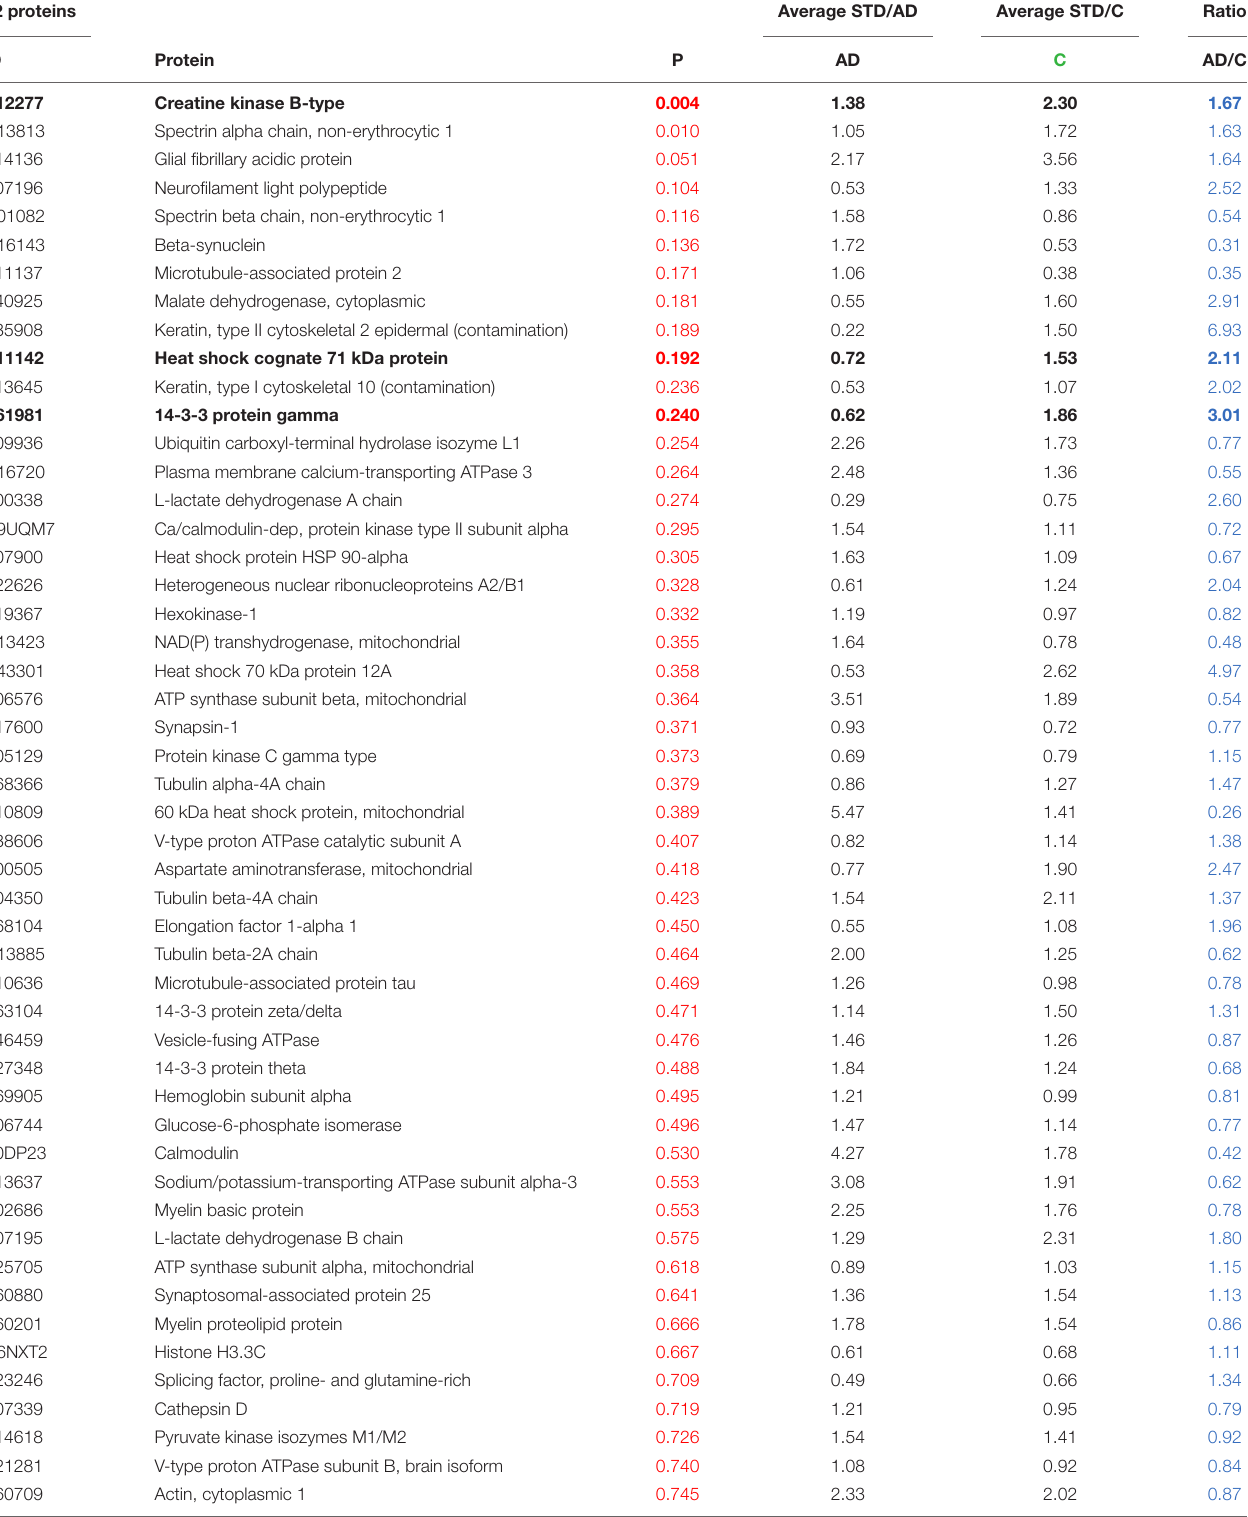
TABLE 2 | Proteins detected by LCM-proteomics in at least two subjects from each group (AD and control). 62 proteins Average STD/AD Average